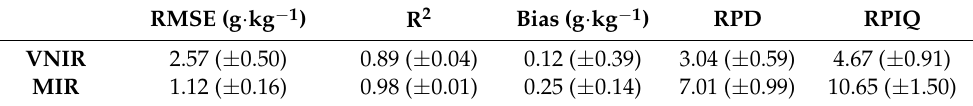
Table 5. Validation accuracy of VNIR and MIR SOC models for the ‘best-case’ scenario with averaged spectral data from all measurement series (VNIR AVG and MIR AVG ) and averaged SOC reference data from all three laboratories. Statistics represent average values of 100 randomized runs of the nested cross-validation approach with two standard deviations of their respective distributions given in parentheses. RPD (ratio of performance to deviation) and RPIQ (ratio of performance to interquartile range) scores represent the ratios of reference SOC standard deviation and interquartile range, respectively, to the RMSE of the predicted SOC values.